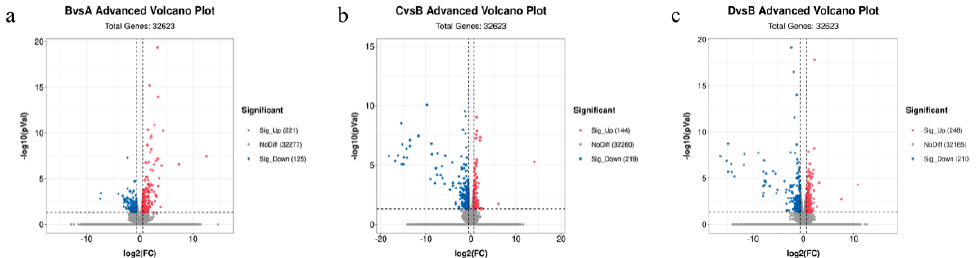
Figure 2. Volcano plot of DEGs among the study comparison groups. ( a ) Volcano plot of DEGs in BvsA. ( b ) Volcano plot of DEGs in CvsB. ( c ) Volcano plot of DEGs in DvsB. A: control group; B: treadmill group; C: acupoint catgut embedding group 1; D: acupoint catgut embedding group 2; DEGs: differentially expressed genes.